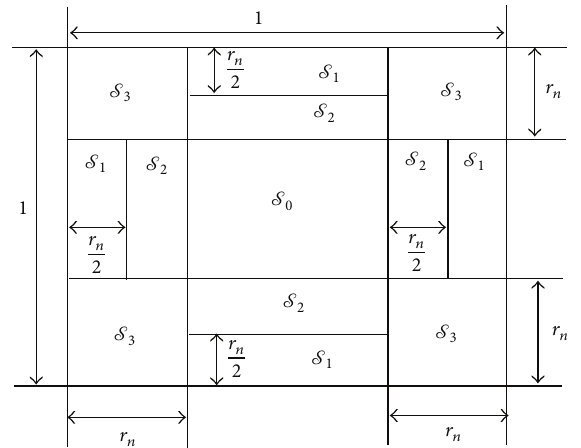
Figure 1: The unit square S and its divisions S 0 , S 1 , S 2 , and S 3